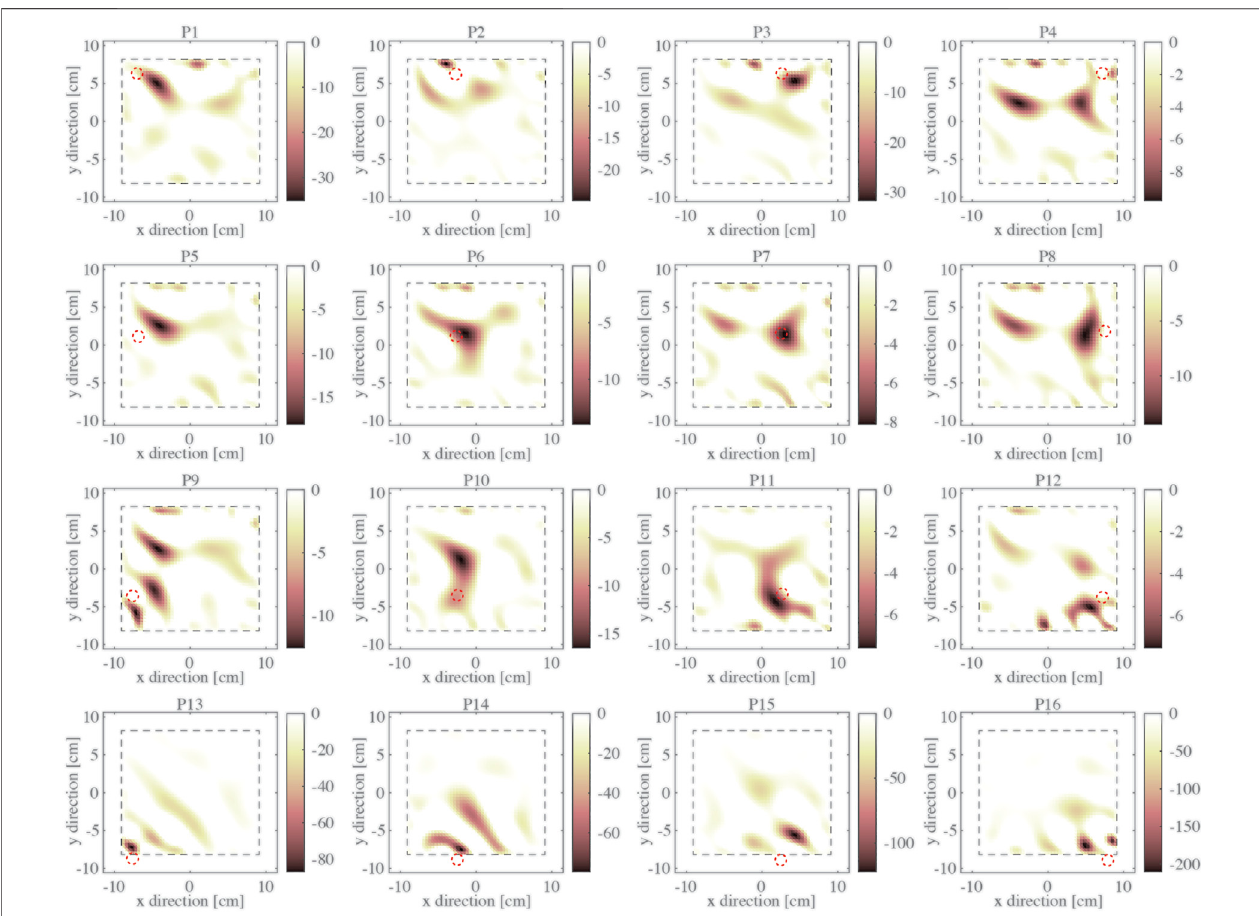
FIGURE 4 | Conductivity distributions obtained using the TV method for Test